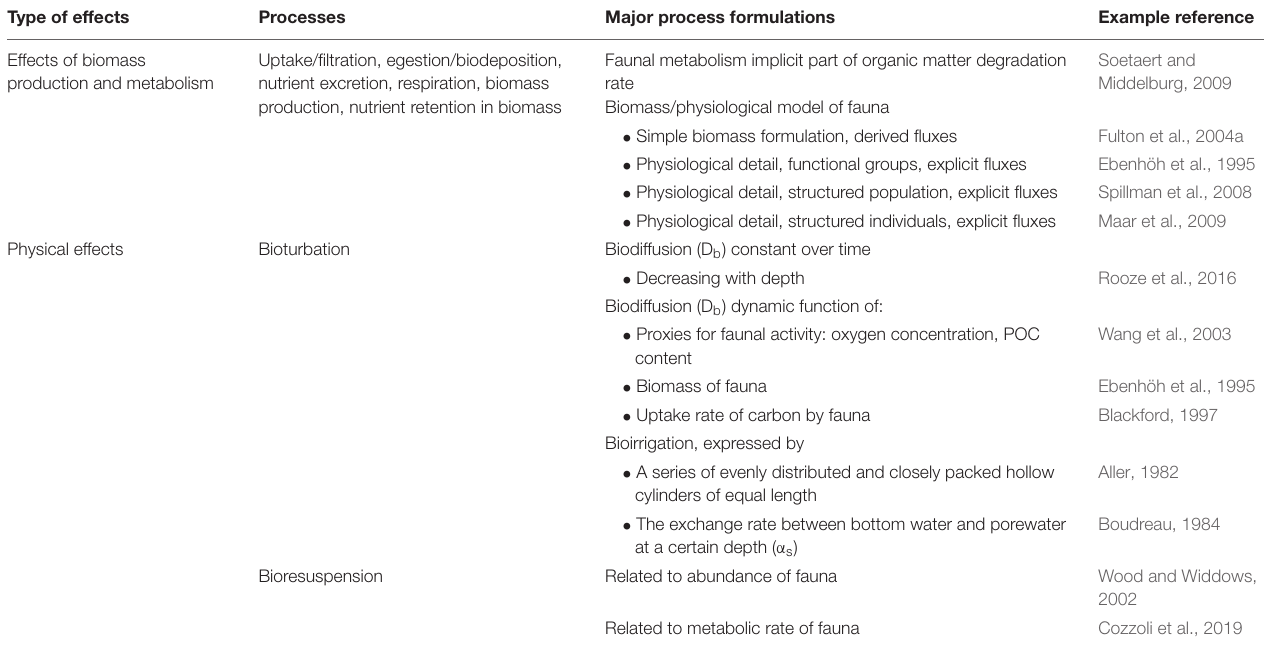
TABLE 2 | Summary of the main approaches to model benthic faunal processes affecting benthic carbon and nutrient fluxes